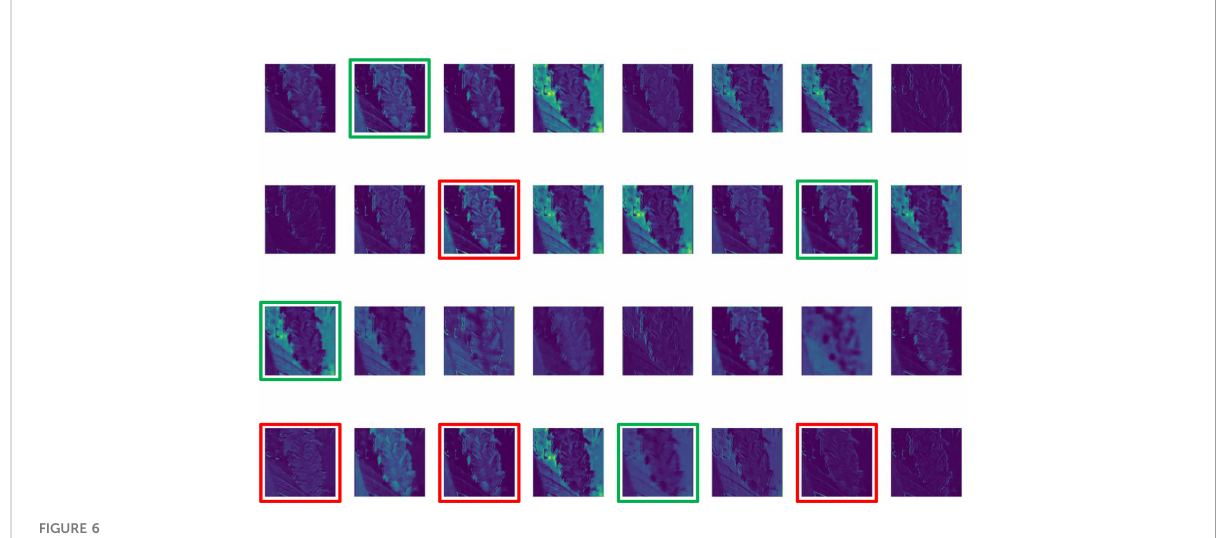
FIGURE 6 Partial feature map extracted based on feature fusion